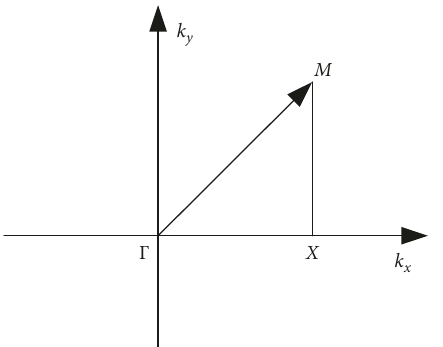
Figure 5: Main direction (MGX) in the reciprocal space. Table 1: Material properties of the PMP-LR in simulations.